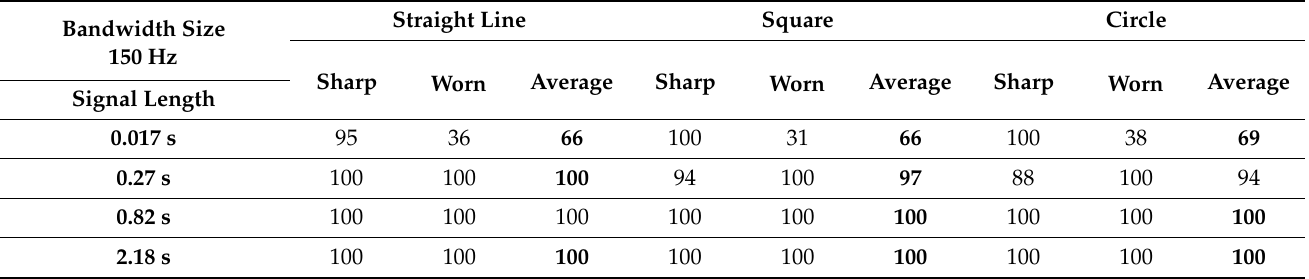
Table 5. Tool wear classification rate with the Z-axis vibration signal and a 150 Hz bandwidth size (model trained by straight line data).